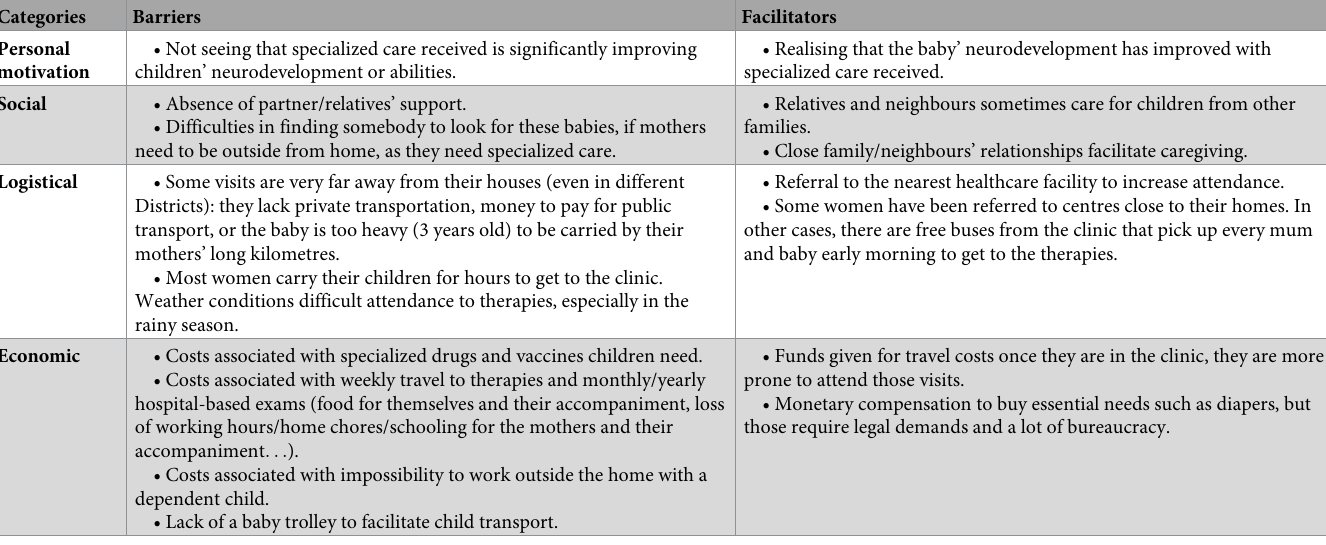
Table 3. Main barriers and facilitators affecting adherence to medical follow-up of microcephalic